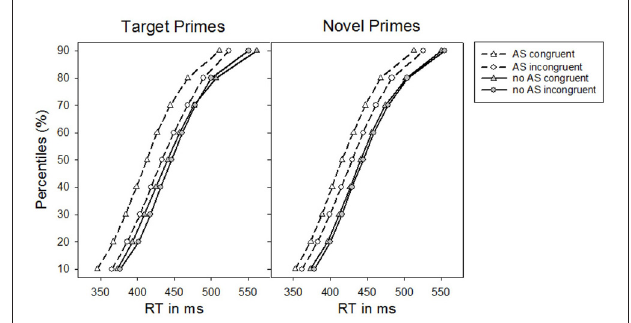
FIGURE 4 | Percentiles of participants’ response times (RTs) in Experiment 2 as a function of the absence vs. presence of an alerting signal for target primes and novel primes,